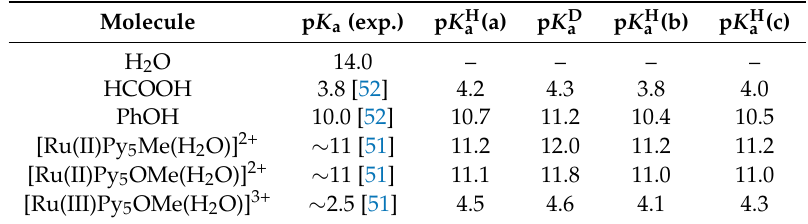
Table 4. All results presented here are calculated at 320 K, for a cubic box with a side length of 15.6406 Å, over a trajectory of about 20 ps (where the first 5 ps were not included in the evaluation). The p K a values were calculated using the probabilistic method for a R c value of 1.26 Å determined for D 2 O. The p K H a (a) was obtained referencing the calculations to H 2 O i.e., a R c of 1.24 Å. The p K D a values were converted to p K H a values according to Equation (10) (b), respectively Equation (13) (c). Molecule p K a (exp.)